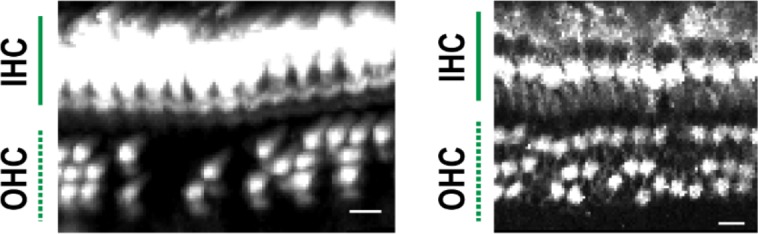
Representative examples of hair cell images where manual estimation of cell loss was difficult.The number of lost cells is difficult to estimate when the size of cell-negative area increases in the basal turn (left). Disorganized rows of OHCs were frequently observed in the apical turn (right). Identification of lost cell positions is difficult when cell density is not high enough to estimate the rows (left) or cells are not aligned as horizontal rows (right). Scale bars, 10 μm.